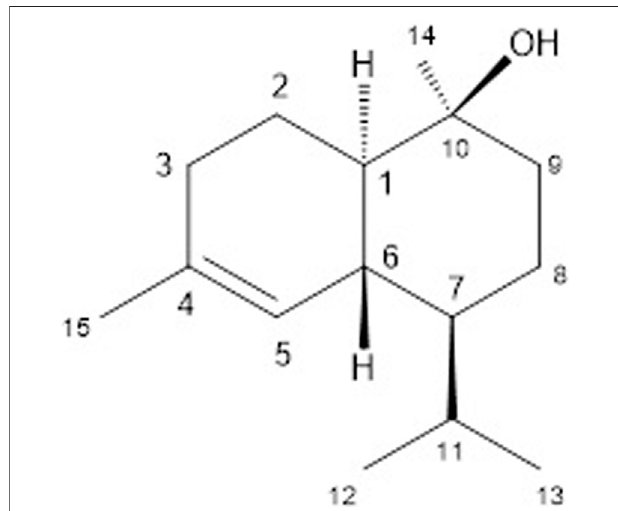
FIGURE 1 | - Structure of (-)-T-cadinol ( 1 ).